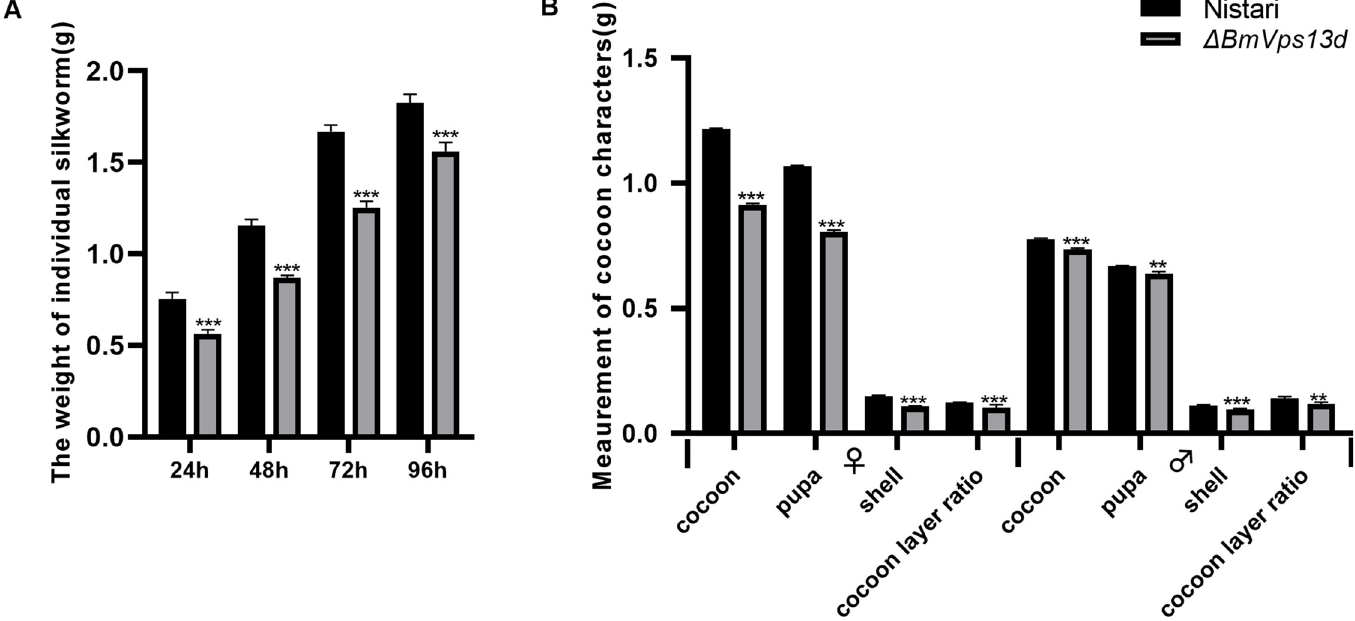
Fig 7. Body weight and cocoon characteristic evaluation of the Δ BmVps13d mutants. (A) Body weight comparisons of individual silkworms. Samples were collected every 24h from day 1 to 4 of the fifth instar larval stage. (B) Cocoon characteristic comparisons, including the weights of cocoons, pupae, and cocoon shells, Samples: Nistari (black), Δ BmVps13d (grey). A two-tailed t -test is used to evaluate the differences between the Nistari and Δ BmVps13d . P -value annotations see Fig 2.